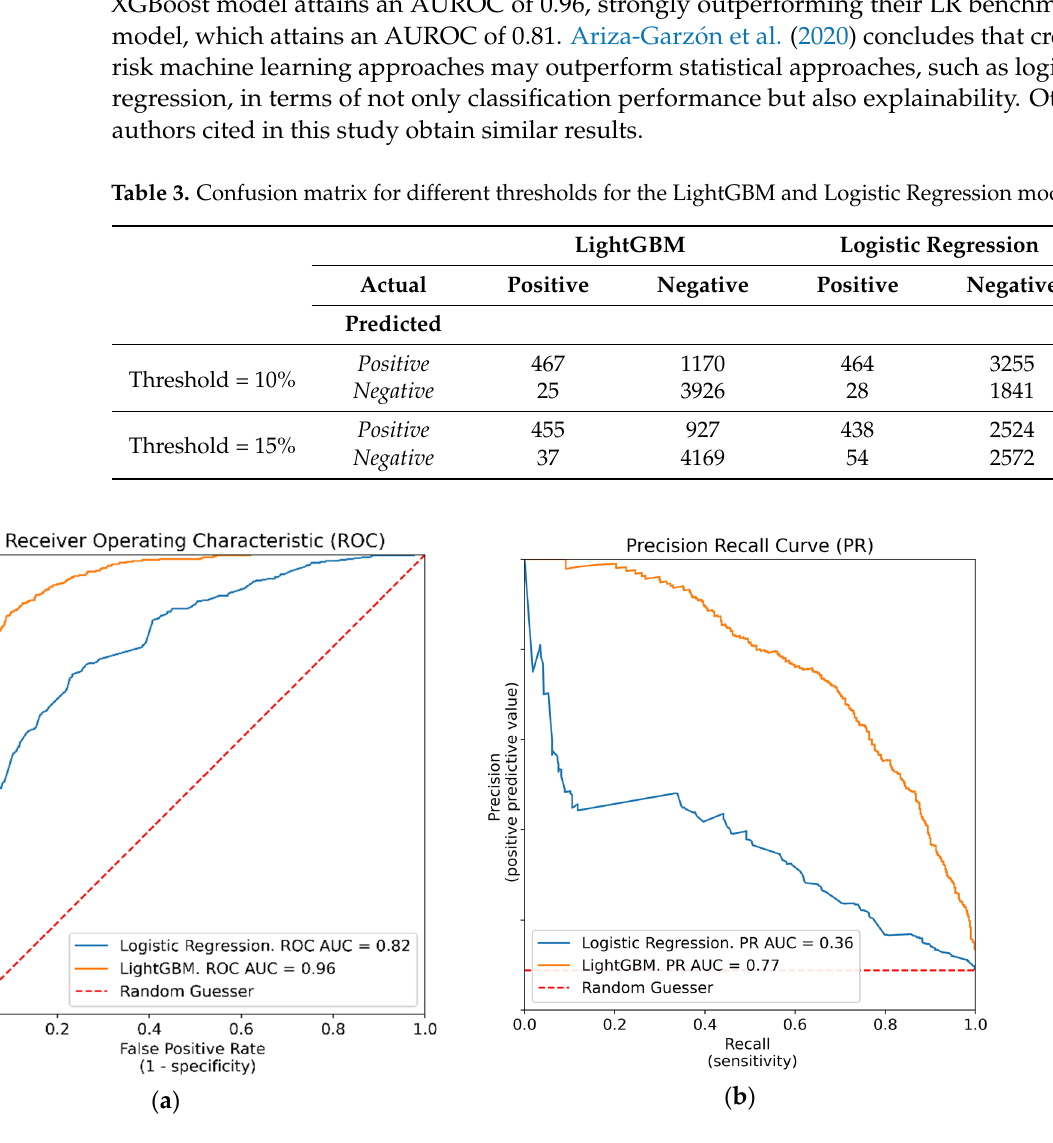
Figure 4. Evaluation curves. ( a ) ROC plot and ( b ) PR plot comparing the performance of the LightGBM and LR model. It is clear that LightGBM outperforms LR with a 17% and a 114% increase in ROC AUC and PR AUC,